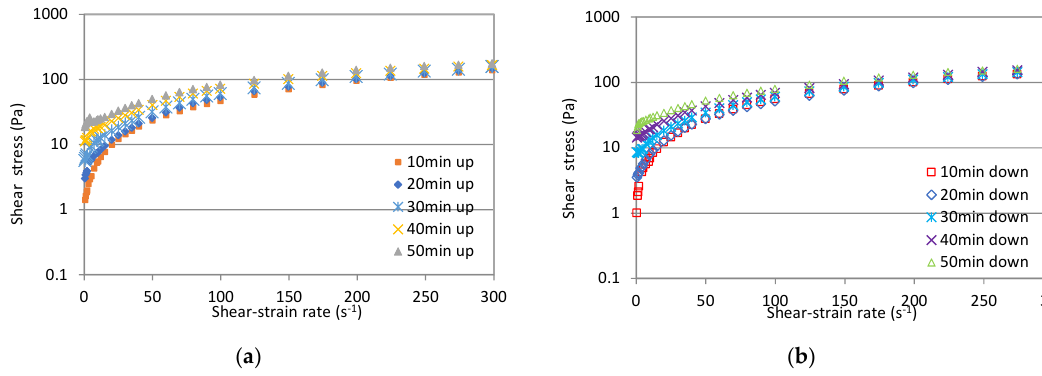
Figure 4. Shеar strеss curvеs of grout with 0.1% PP fibеrs: ( a ) up curvе, ( b ) down curvе.